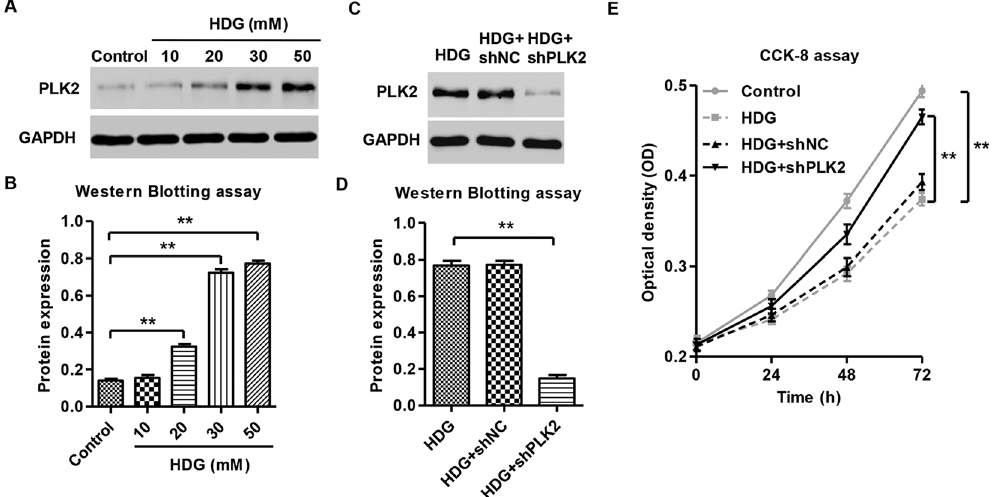
Figure 2. High D-glucose induced PLK2 expression. ( A,B ) Representative blots of PLK2 upregulation with different D-glucose concentrations. ( C,D ) Lentiviral encoding shRLK2 significantly reduces PLK2 expression in the presence of HDG in mouse podocytes. ( E ) Cell viability in response to HDG was significantly improved in shPLK2 group in mouse podocytes using CCK-8 assay. ** P <